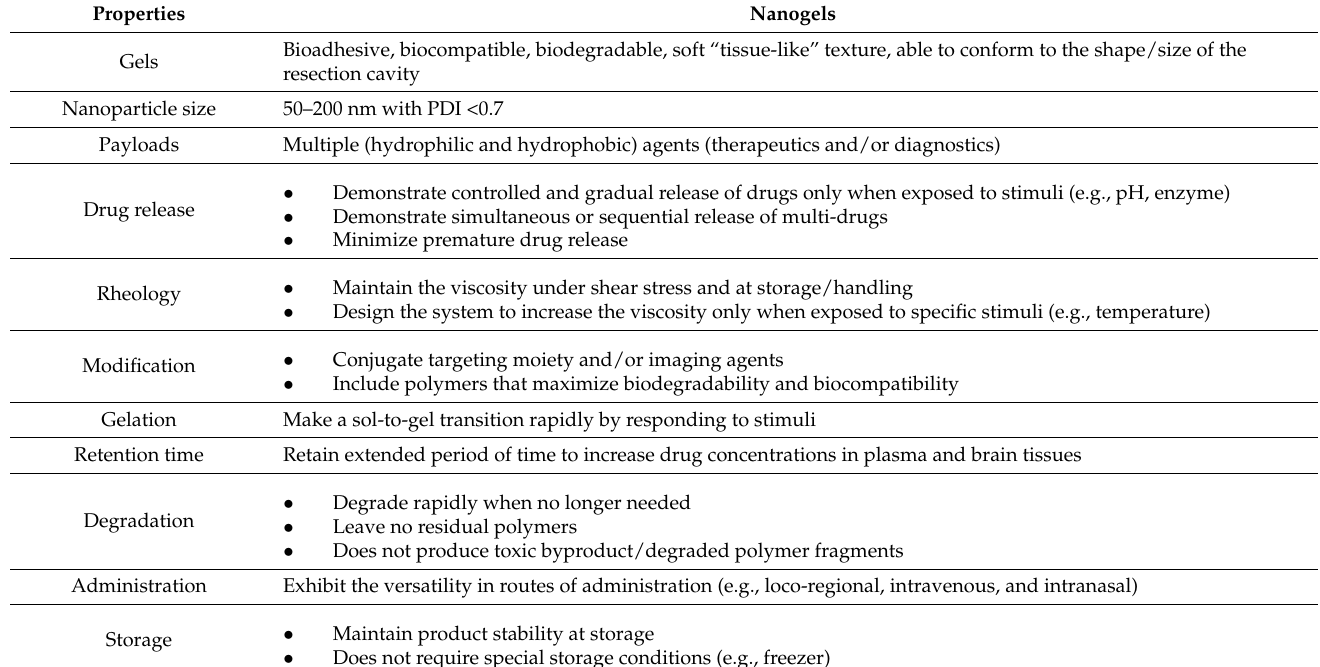
Table 3. List of key desirable properties of nanogels desired for brain cancer